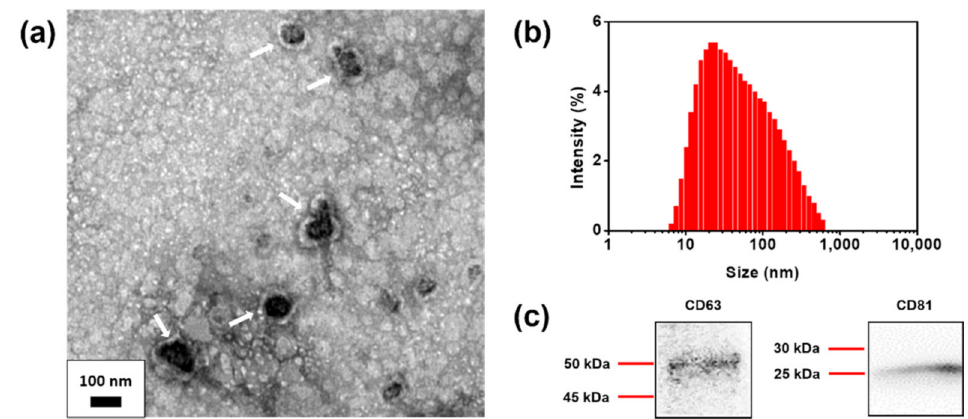
Figure 2. Characterization of human foreskin fibroblast (HFF) exosomes. ( a ) Transmission electron microscopy (TEM) image of HFF exosomes, indicated by arrows. ( b ) Size distribution of HFF exosomes using dynamic light scattering (DLS). ( c ) HFF exosomes immunoblotting using exosome marker proteins, CD63 and